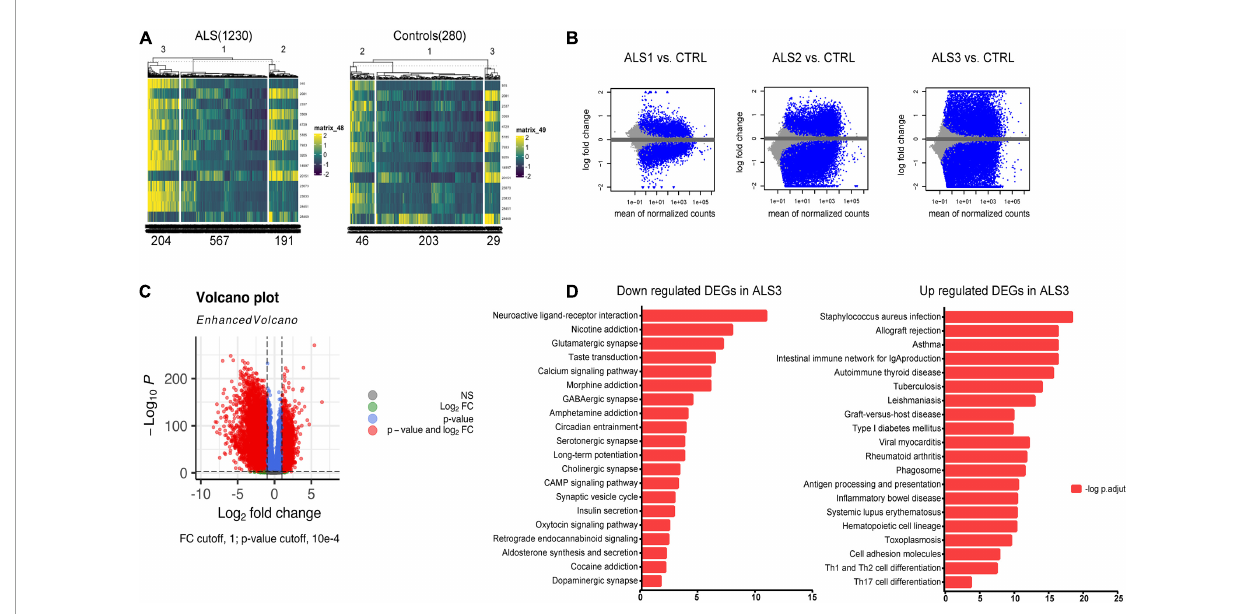
FIGURE5 KEGG pathway analysis based on FIRGs that significantly altered in ALS. (A) Sample clusters based on expression matrix of 15 hub genes. (B) MA plot of DEGs of each ALS subgroup vs. controls. (C) Volcano plot of DEGs between ALS3 and controls. (D) KEGG pathway analysis of downregulated and upregulated DEGs in ALS3 subgroup, compared with non-neurological controls.